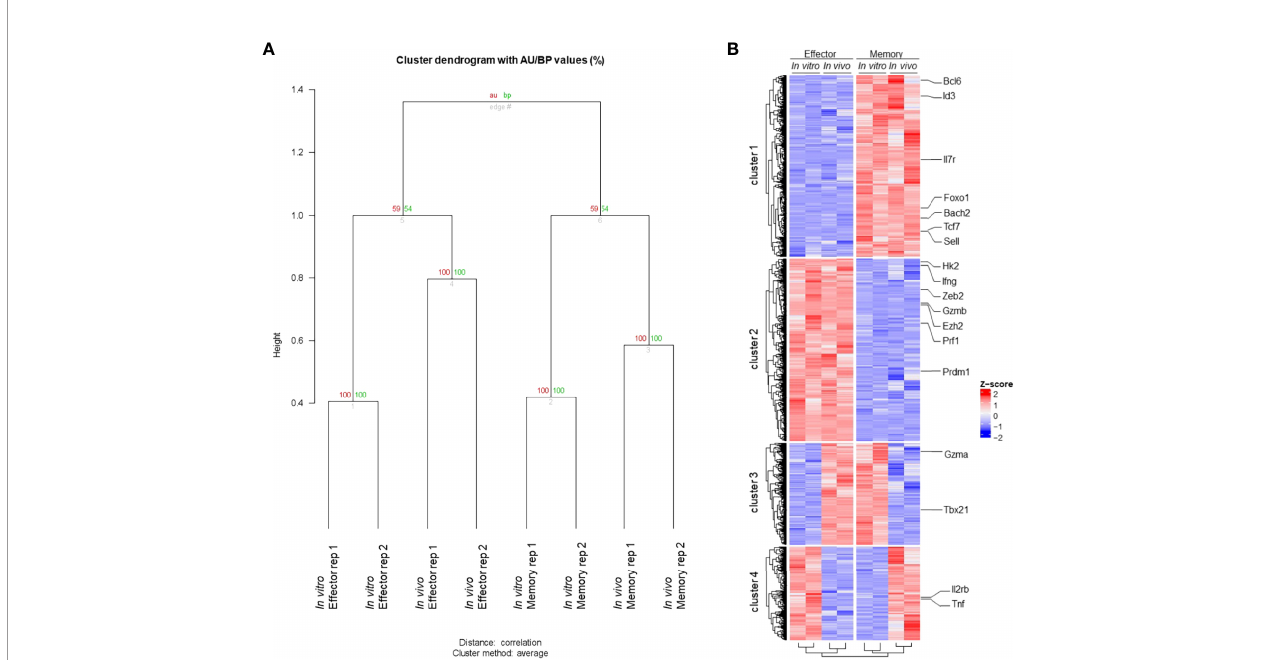
FIGURE 3 | Transcriptome Pro fi le of Memory and Effector CD8 T Cells. (A) Clustering global transcriptome of memory and effector CD8 T cells from in vivo and in vitro samples. The samples were clustered based on the global transcriptome using “ average ” for cluster method and correlation-based dissimilarity matrix method for distance metric. Two bootstrapping algorithms, AU (approximately unbiased – in red) and BP (bootstrap probability – in green), were used to calculate the similarity between samples and are represented as values (0 to 100) for each branch. (B) Hierarchical clustering of the heatmap displaying gene expression from memory and effector CD8 T cells from in vivo and in vitro samples. Hierarchical column clustering showing samples grouped by cell type (effector and memory) and sample type ( in vitro and in vivo ). The hierarchical row clustering showed four bright patterns of gene expression clusters. The criteria to select those genes were a p < 0.05 (False Discovery Rate (FDR) < 0.1), and the gene expression is displayed by row as a z-score. All featured labeled genes showed FDR <